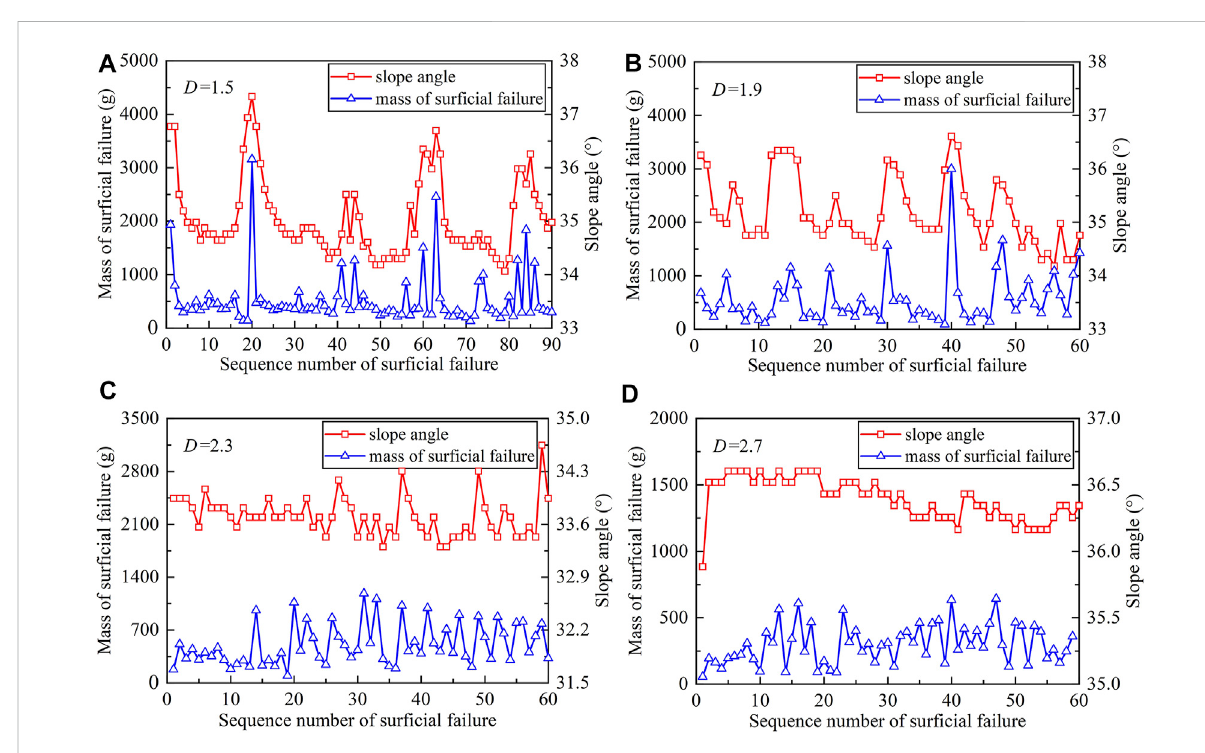
FIGURE 9 Mass ofsur fi cial failure and fl uctuation of theslope angle for granular slopes with differentfractal dimensions (A) D =1.5; (B) D = 1.9; (C) D =2.3; (D) D = 2.7.